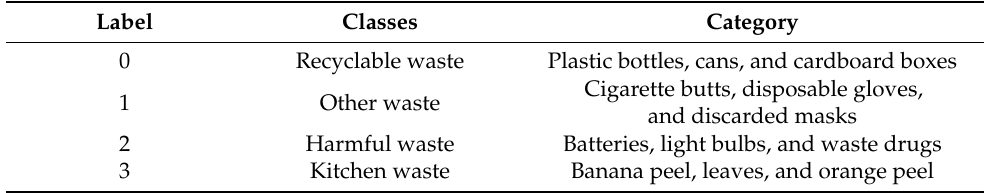
Table 2, with a total of 1694 RGB color images. Table 2. HPU_WASTE Dataset